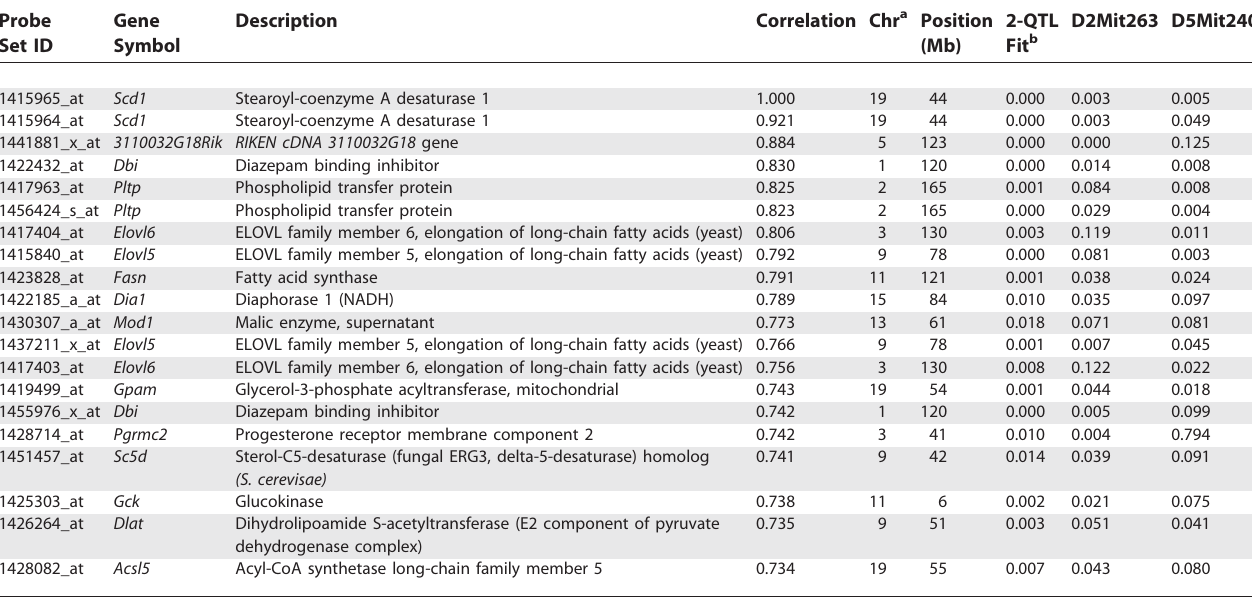
Table 1. Top 20 Gene Expression Traits Correlated with Scd1 Are All Lipid Metabolism Genes Probe Gene Set ID Symbol